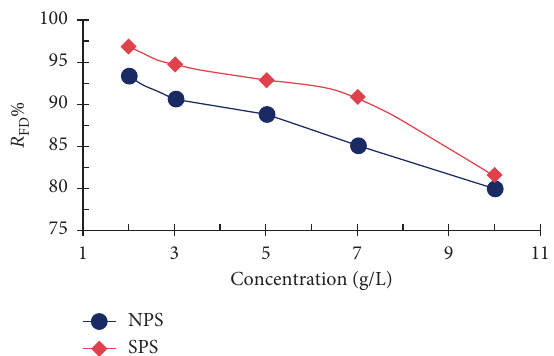
Figure 5: Adsorbent dose impact of NPS and SPS amounts on the FD removal (10mg/L FD concentration; 50ml solution volume; 3h contact time; and 25 ° C temperature).